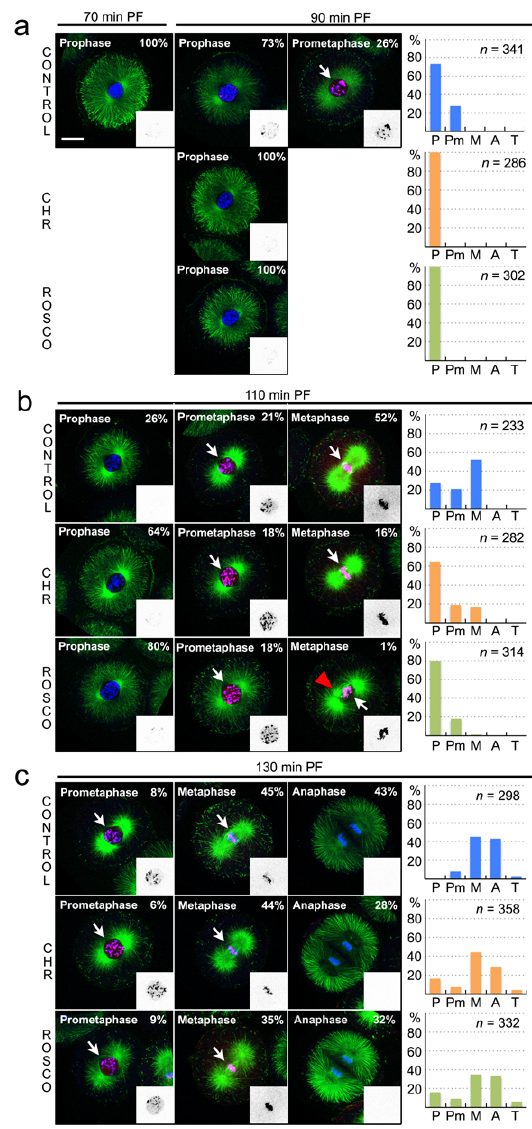
Figure 7. Neither CHR-6494 nor Roscovitine prevent T3H3 phosphorylation during the first embryonic division in S. granularis . ( a – c ) Embryos were assigned to five di ff erent phenotypic categories, according to their morphology. For each sample, representative images illustrating the di ff erent phenotypes found are shown in the same row. Pictures correspond to confocal equatorial optical sections obtained imaging embryos immunostained for Tubulin (shown in green), T3H3ph (red and inverted grey-scale in the small insets) and DAPI (blue). Scale bar, 25 µ m. The relative proportions of the di ff erent categories are reported on each image and have been plotted as a series of histograms shown on the right panel of each row. The number of embryos considered for the quantitative analyses is also shown on the corresponding graphs. Abbreviations used: P, Prophase; Pm, Prometaphase; M, Metaphase; A, Anaphase; T, Telophase. ( a ) All embryos were in prophase in a sample collected before drug addition, at 70 min PF. In the control batch, samples collected at 90 min PF included 26% of embryos in prometaphase, all displaying high levels of T3H3ph (white arrow). This phenotypic category was absent in the drug-exposed batches. ( b ) Samples collected at 110 min PF contained embryos in prometaphase and metaphase, all showing a bright T3H3ph staining (white arrows). In the batch exposed to Roscovitine, all the embryos in metaphase presented ectopic spindle poles (red arrowhead). ( c ) In the 130 min PF samples, embryos in prometaphase and metaphase displayed normal levels of T3H3ph (white arrows) and the staining disappeared during the